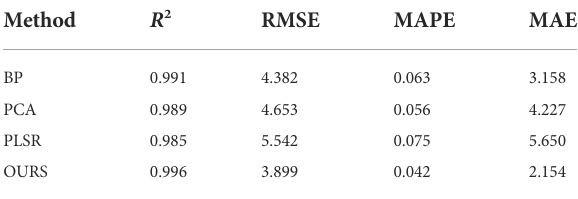
TABLE 2 Evaluation of the model prediction